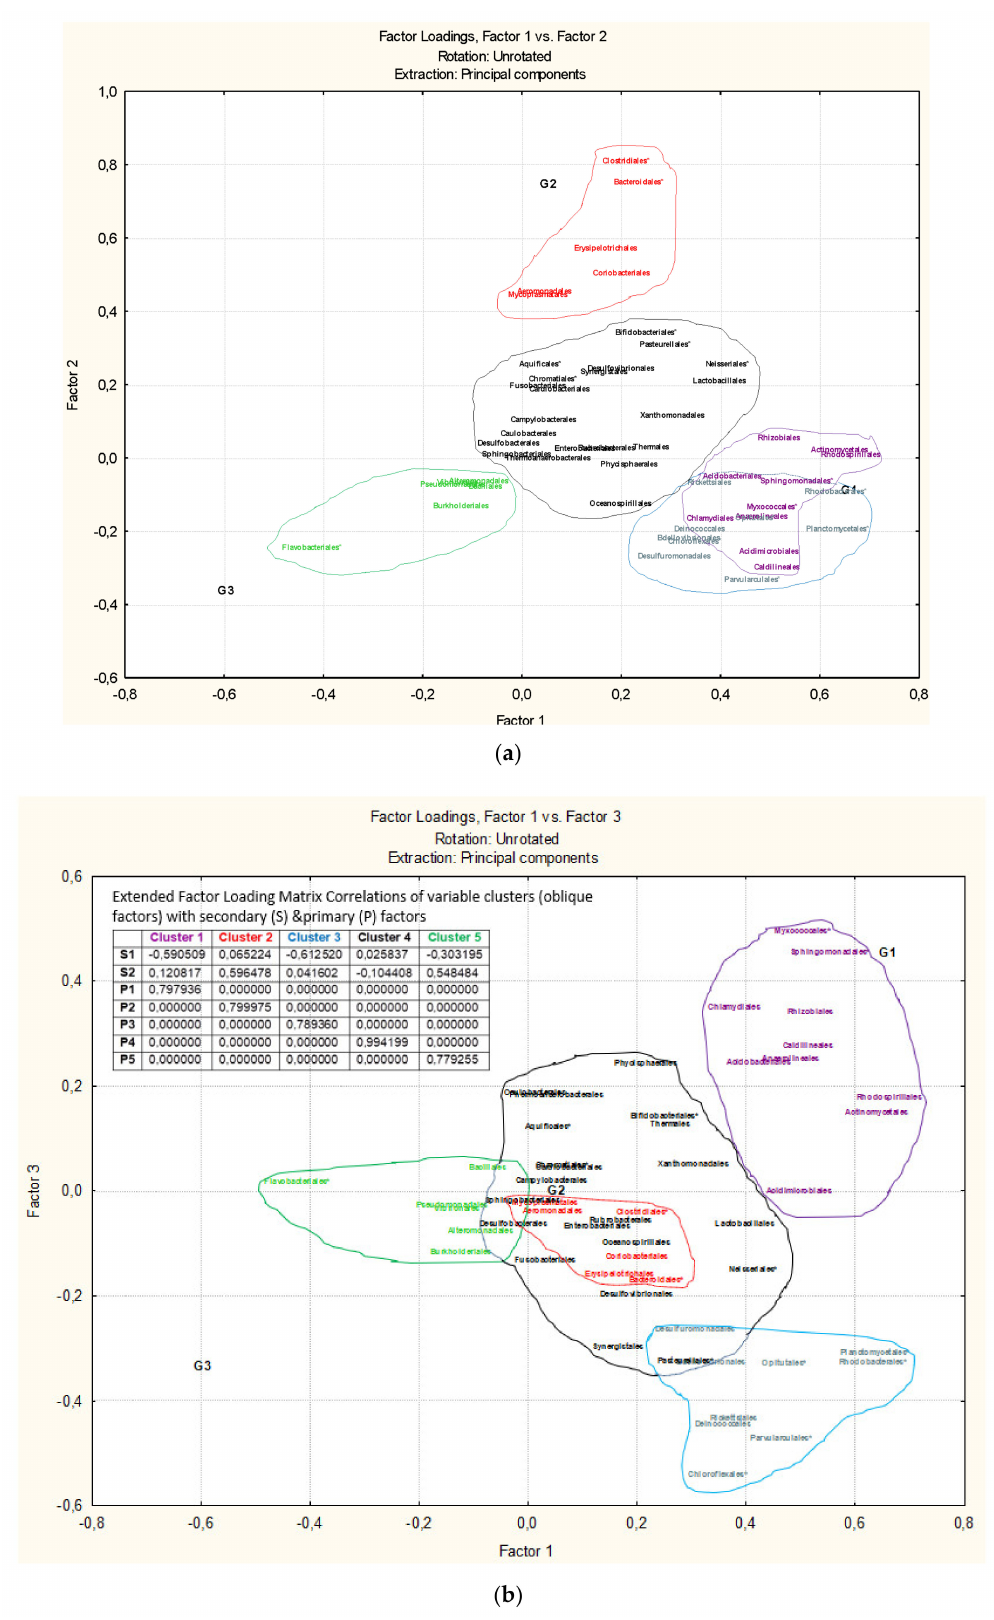
Figure 4. Factorial analysis considering the anisakids samples and bacteria at order levels. In the In the Factorial Space defined by Factor 1 vs. Factor 2 ( a ) and Factor 1 vs. Factor 3 ( b ) is disposed the correspondence with the classified clusters of Figure